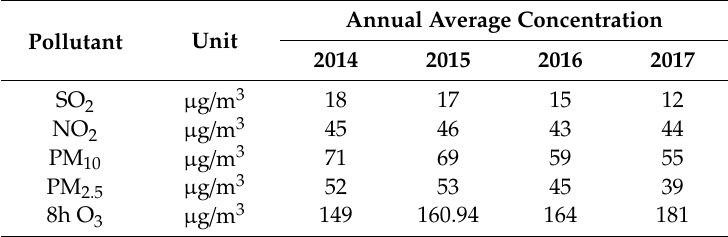
Table 1. Air pollutants and their annual average concentration in Shanghai from 2014 to 2017. Pollutant